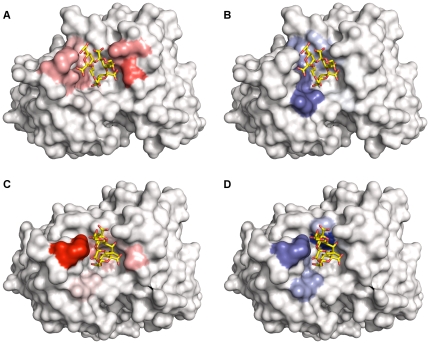
Evaluation of site mapping using high resolution crystal structure complexes.Kdoα(2→4)Kdoα(2→4)Kdoα(2-OAll) binding to S73-2 (PDB 3HZY) described by hydrogen bonding map (A) and van der Waals interaction map (B). Kdoα(2→8)Kdoα(2→4)Kdoα(2-OAll) binding to S25-39 (PDB 3OKO) described by hydrogen bonding map (C) and van der Waals interaction map (D). The color depth indicates the level of involvement of a particular residue in ligand recognition; more strongly illuminated residues are more involved in ligand recognition than weakly illuminated residues. The crystal structure binding mode is shown in each structure in sticks colored by atom type (C, yellow; O, red). Images rendered using PyMOL [64].